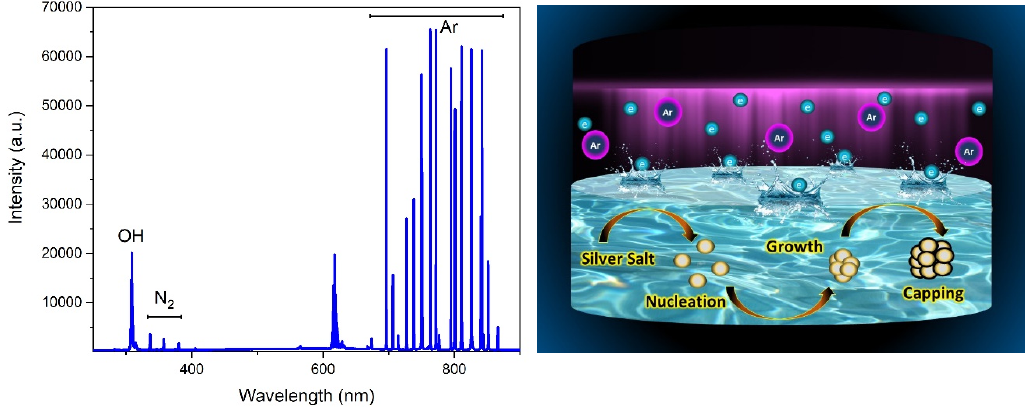
Figure 5. OES spectrum of the Argon DBD plasma used to treat the precursor solution ( left ); Figure 5 . OES spectrum of the Argon DBD plasma used to treat the precursor solution (left); schematic schematic representation of the DBD plasma assisted silver nanoparticle formation ( right representation of the DBD plasma assisted silver nanoparticle formation (right) .